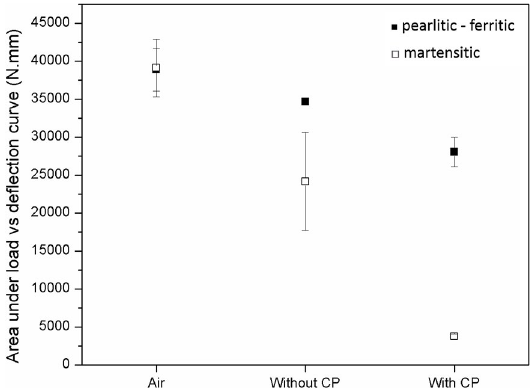
Figure 12. Comparative values of area under load vs deflection curve for both materials in the studied environments.